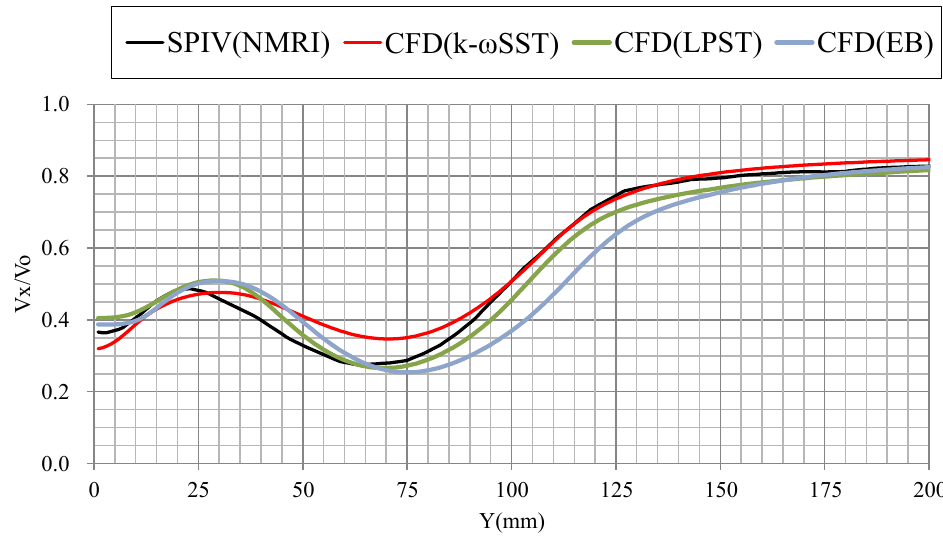
Figure 11. Longitudinal velocity distribution along the horizontal line above the propeller shaft calculated by low Reynolds number models.